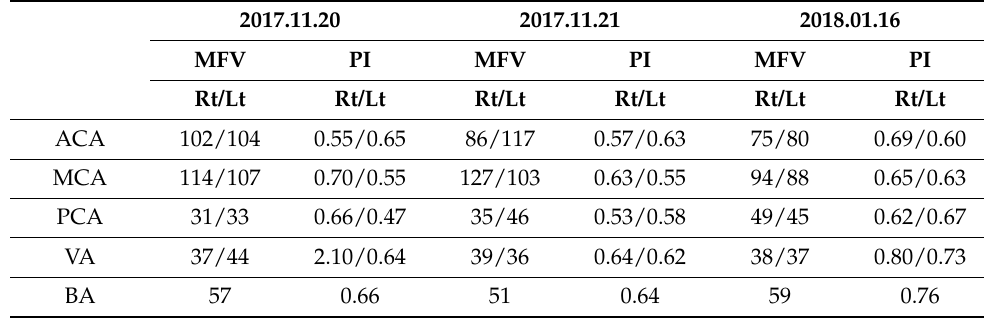
Table 1. Serial transcranial doppler (TCD) findings on patient.